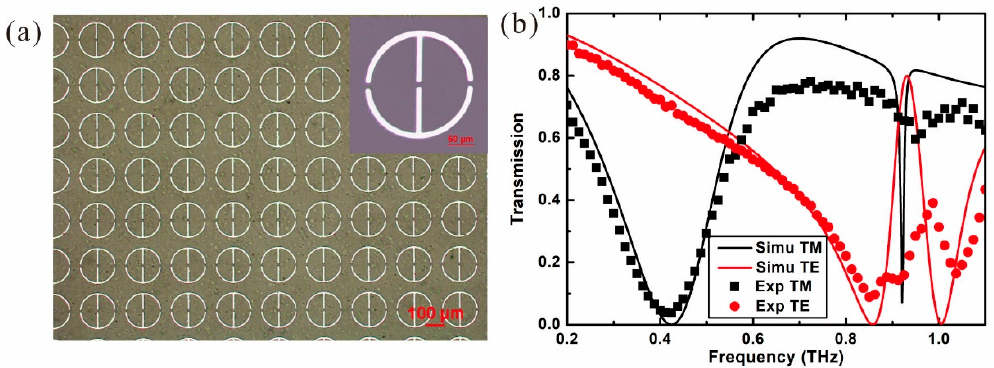
Figure 2. ( a ) Microscope picture of fabricated THz anisotropic metamaterial. ( b ) Simulated and measured transmission spectrum of the metamaterial in the x and y directions.